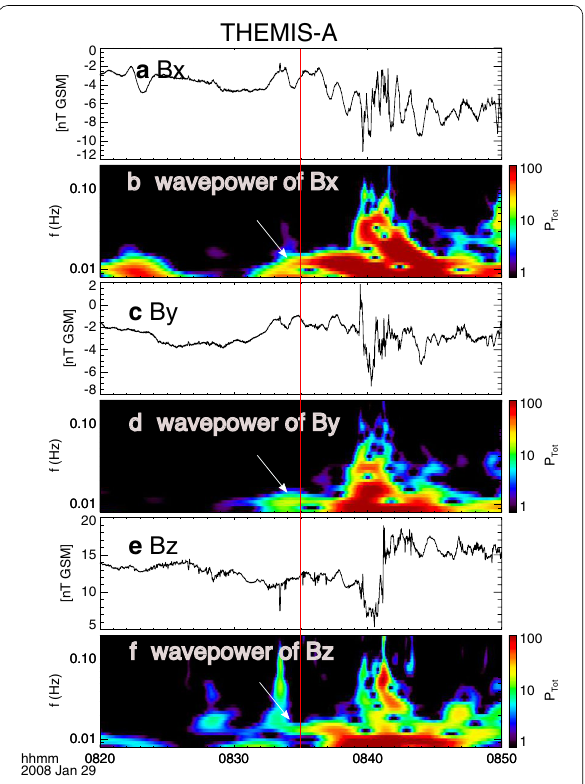
Fig. 3 Wavelet analysis of the vector magnetic field components. The red line marks the time 08:35